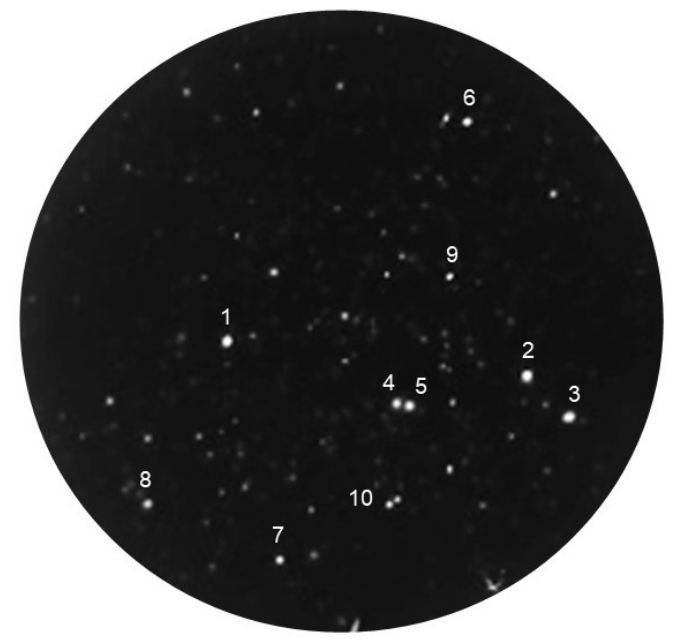
Figure 3. A representative nitrocellulose membrane showing positive clones from the scFv-PhoA library against human IgG. Antigen binding of scFvs to the membrane was detected by chemiluminescence. Seven positive spots that showed the strongest signal intensities were selected for further experiments.